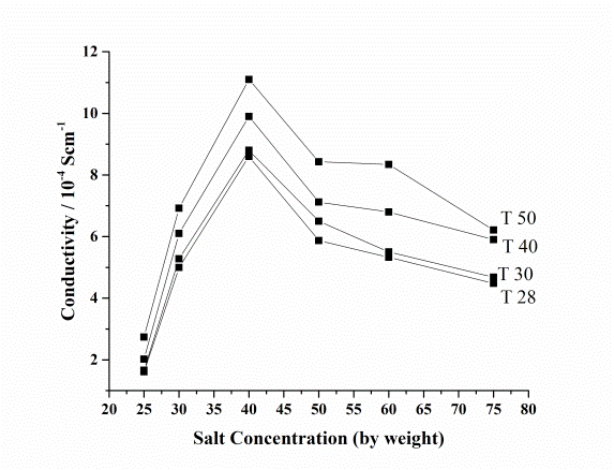
: EC : PC at different 2